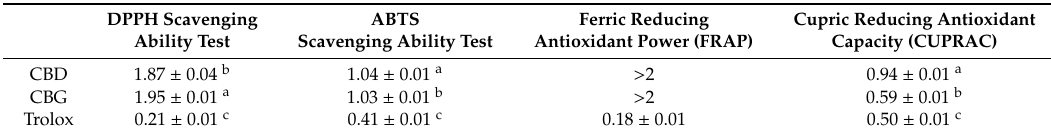
Table 2. Scavenging / Reducing